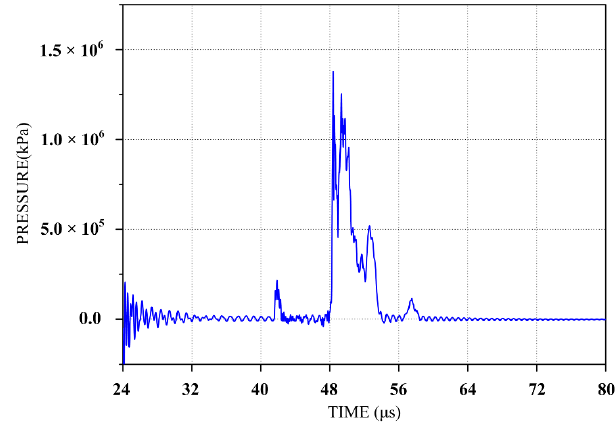
Figure 14. Pressure–time curve at gauge point2.